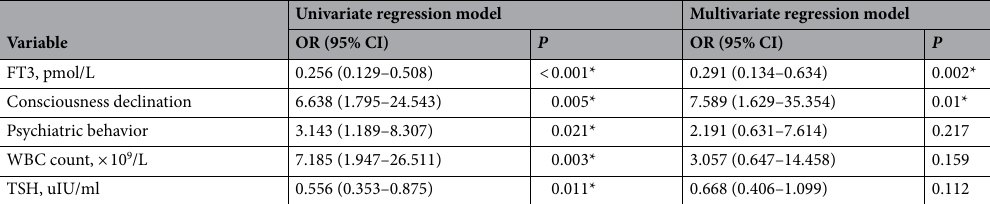
Table 2. Univariate and multivariate logistic regression analysis of predictors obtained within 24 h of admission for ICU admission during hospitalization. In the univariate model, the eligible variables obtained within 24 h of admission and tumor presence were analyzed, and those identified as not predictors of ICU admission during hospitalization ( P > 0.05) were not shown in this table. In the multivariate regression model, the predictive value of FT3 was adjusted by consciousness declination, psychiatric behavior, WBC count and TSH within 24 h of admission. *Indicates P < 0.05. OR, odds ratio; CI, confidence interval; FT3, free triiodothyronine; WBC, white blood cell; ICU, intense care unit; TSH, thyroid stimulating